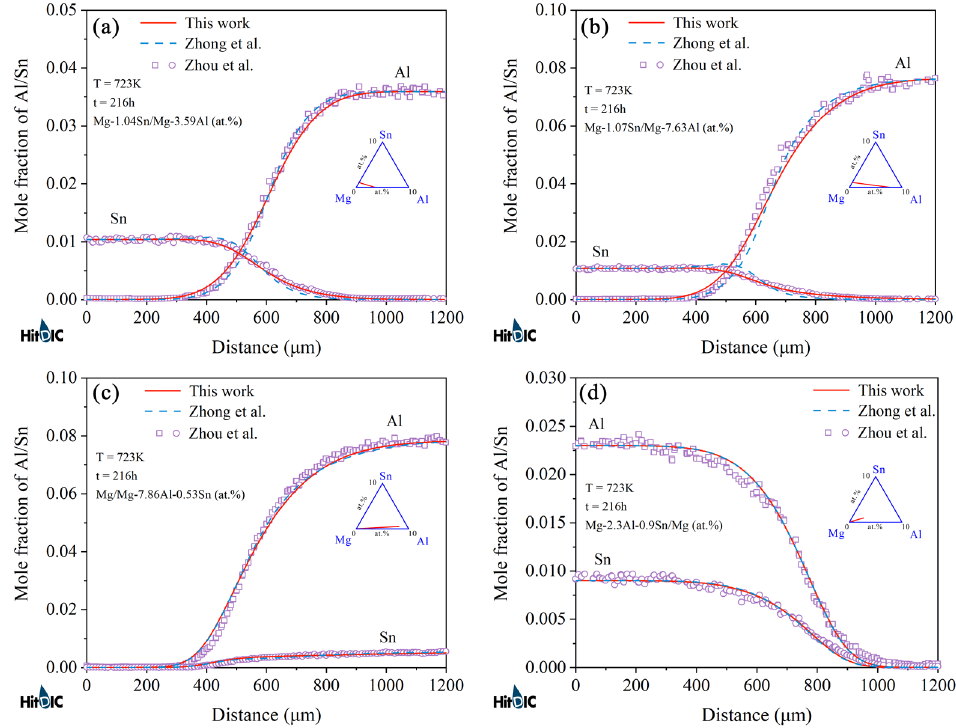
Figure 7. ( a – d ) Model-predicted composition–distance profiles of the different hcp Mg–Al–Sn diffusion couples annealed at 723 K for 216 h from the present atomic mobilities (solid lines) compared with those of Zhong et al. [32] (dashed lines) and the experimental data [37] (in symbols).